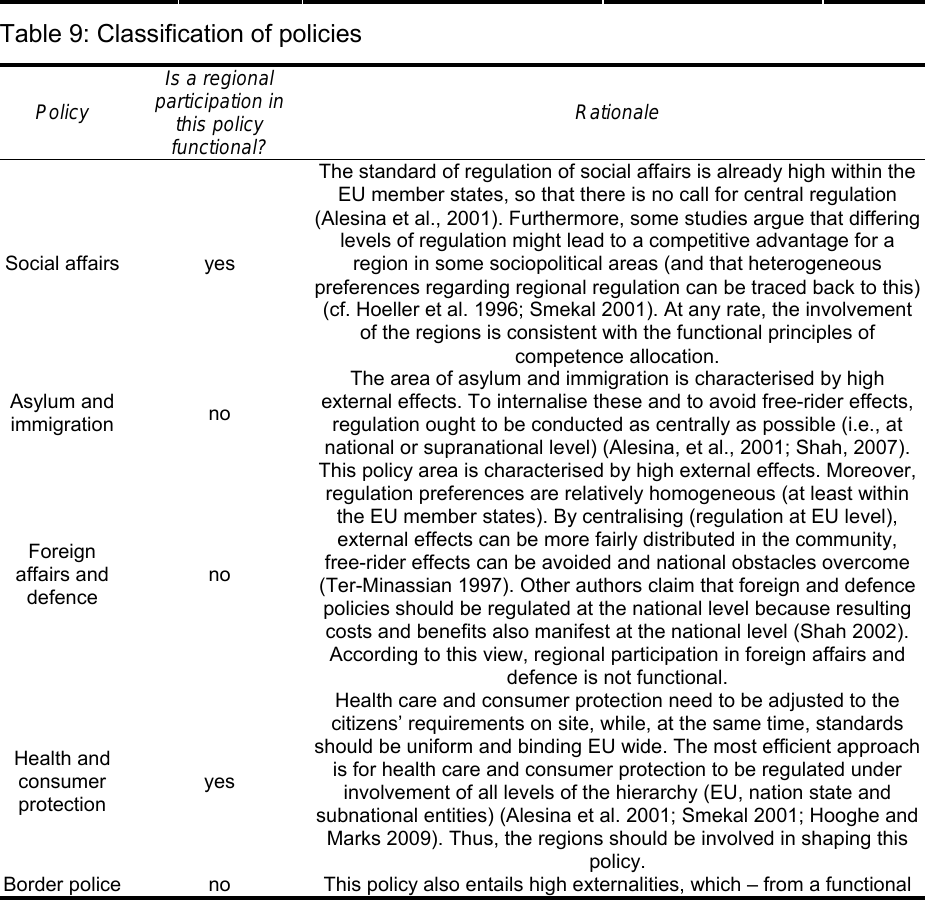
Table 9: Classification of